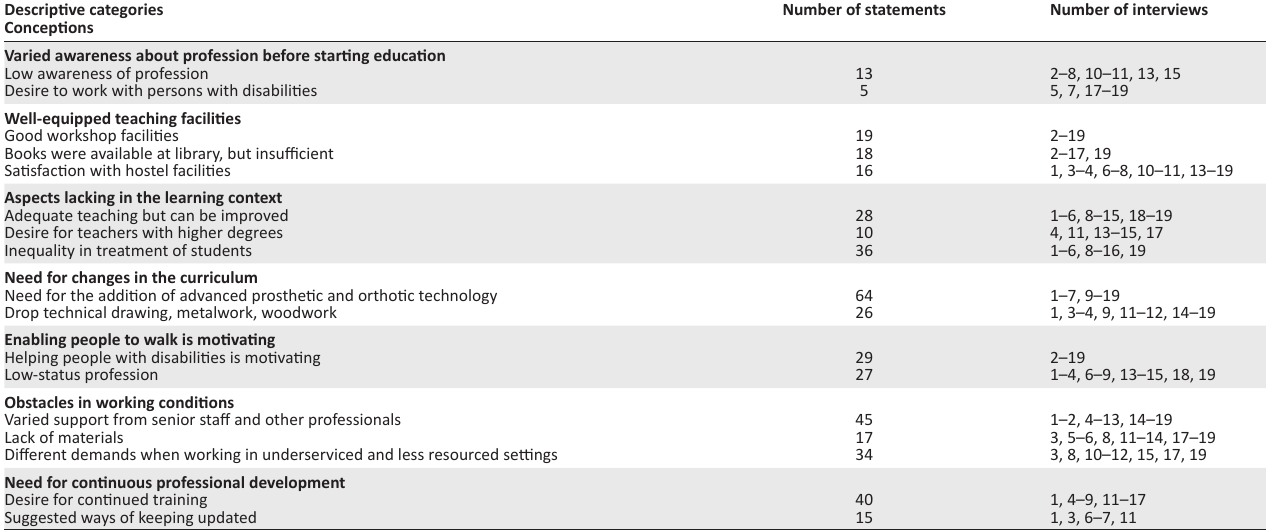
TABLE 2: Graduate perspectives of the prosthetic and orthotic education curricula and